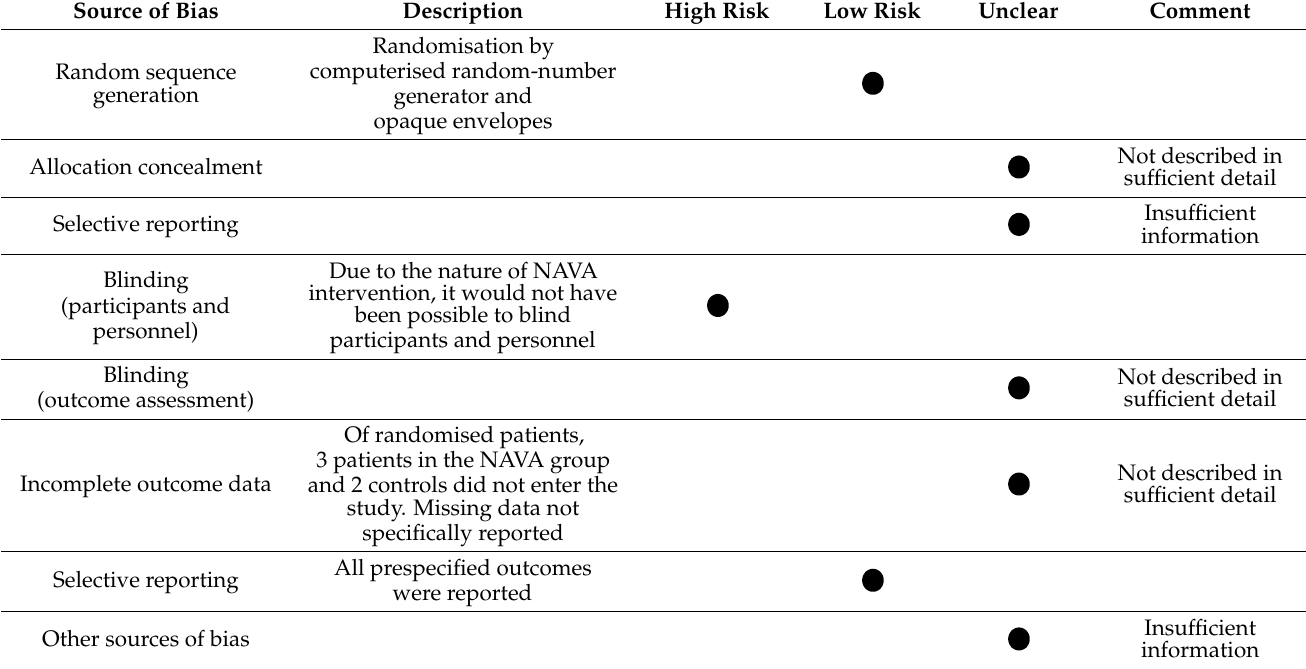
Table 2. Risk-of-bias assessment for Kallio et al., 2015 [27].